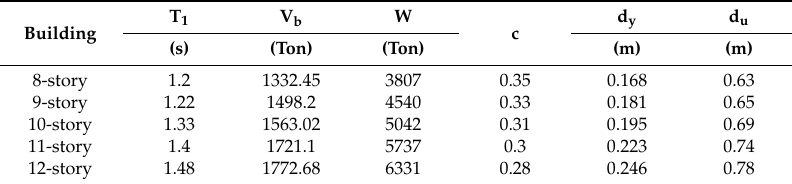
Table 3. Dynamic characteristics of the buildings analyzed.